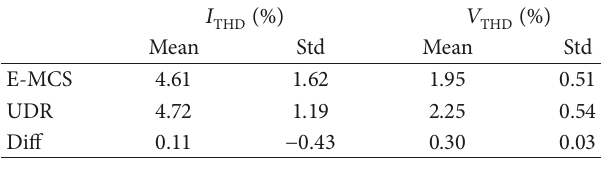
Table 4: THD result of VSCs under normal variation of power.